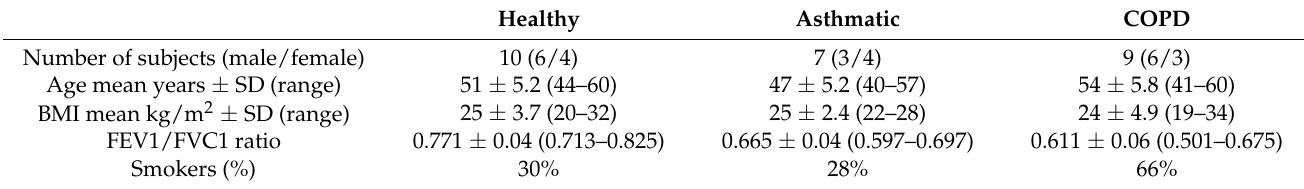
Table 2. Summary of participant demographics ( n =